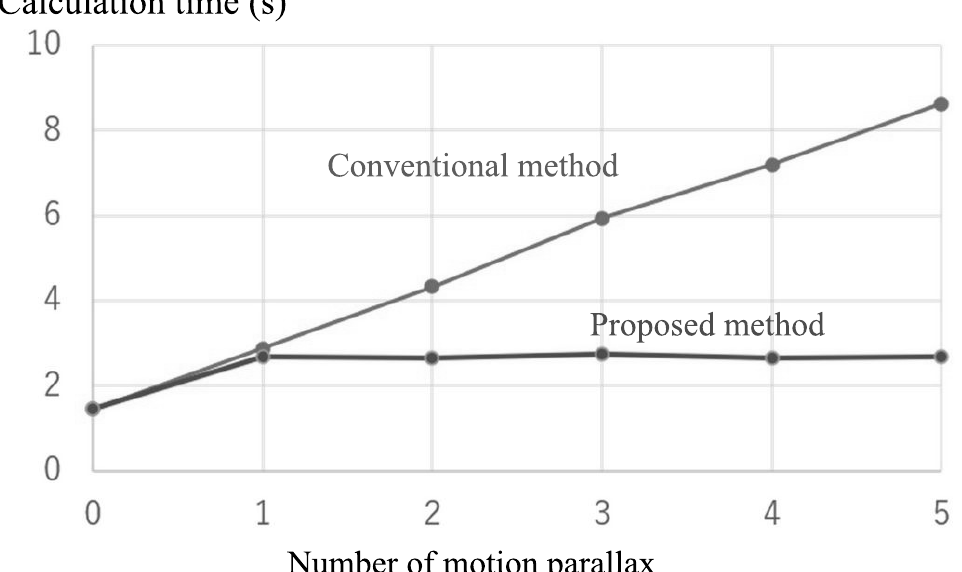
Figure 5. Calculation times of the proposed method and the conventional method as functions of the number of motion